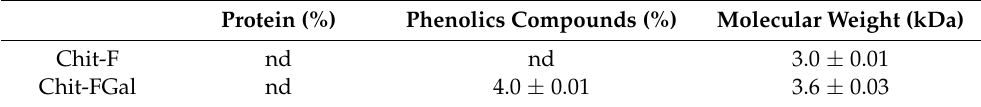
Table 1. Quantification of total proteins and phenolic compounds and determination of their apparent molecular weights.